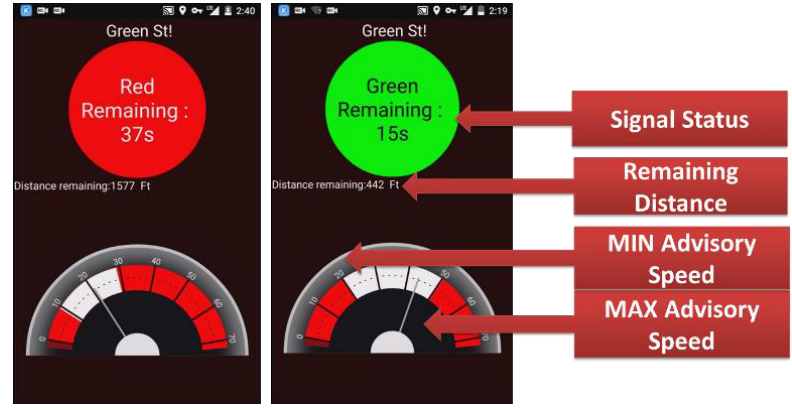
Figure 5. ITSAS mobile application user interface.